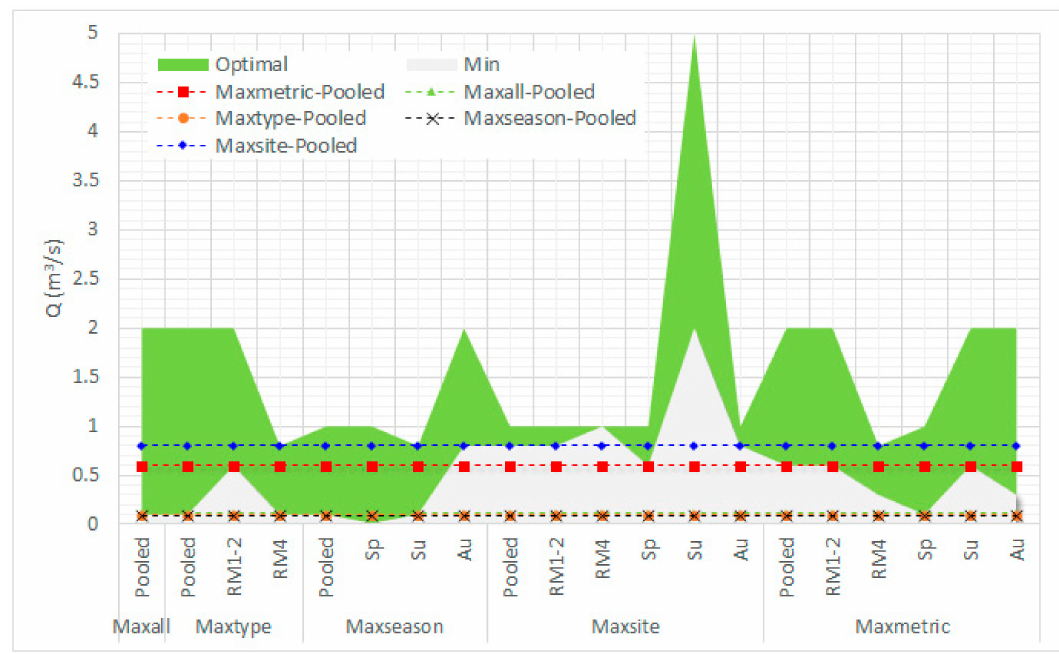
Figure 10. Overall comparison on the selection of the minimum acceptable and optimal environmental flow in the Parapeiros River between the various habitat-suitability calculation-normalization options including seasonal and typological variation (Sp: Spring; Su: Summer; Au: Autumn). Predictions within the green area are considered acceptable (lying between the minimum and optimal environmental flows).